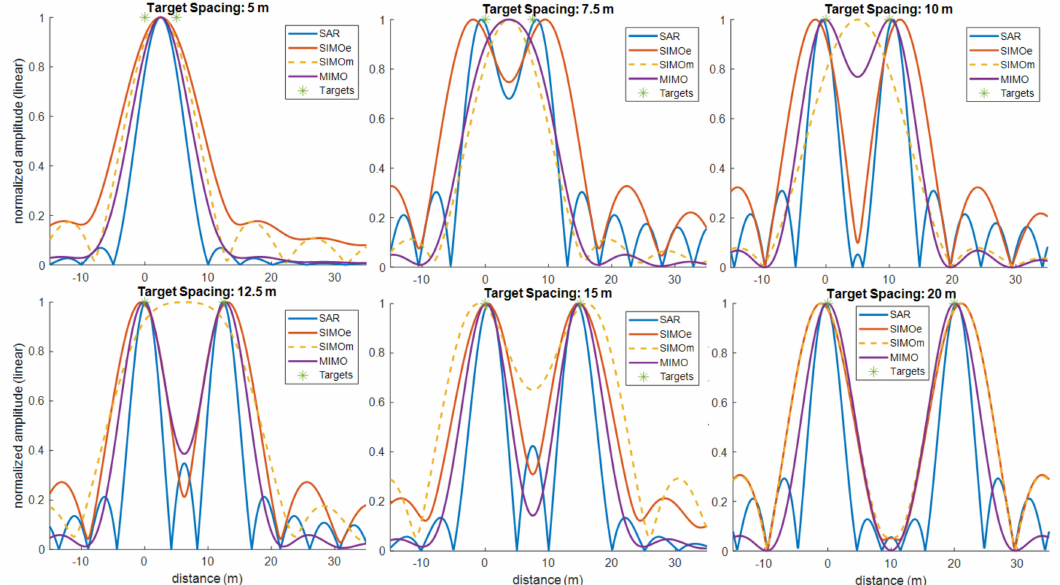
Figure 18. Tomographic “images” in 1D for the SAR, SIMO, and MIMO modes. Green asterisks show the position and reflectivity of the point targets. Distance between the two targets varies from 5 m to 20